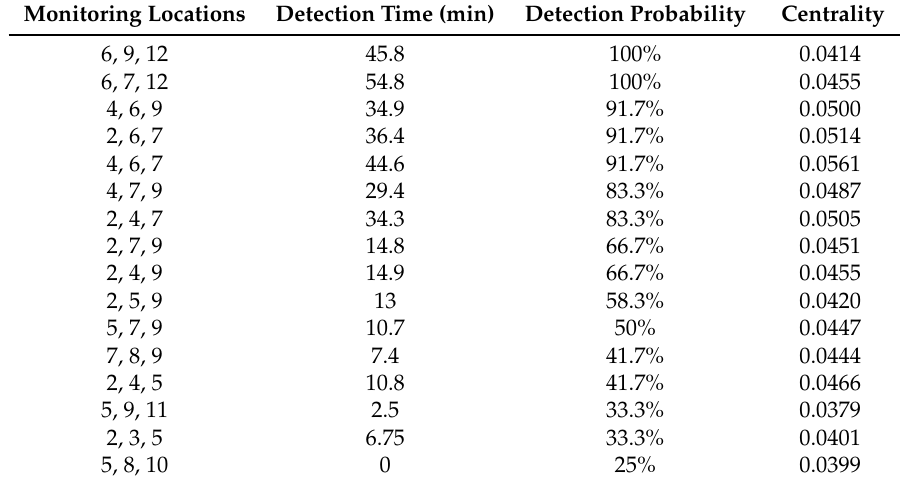
Table 8. Pollution detection time, pollution detection probability and centrality in Pareto frontier.